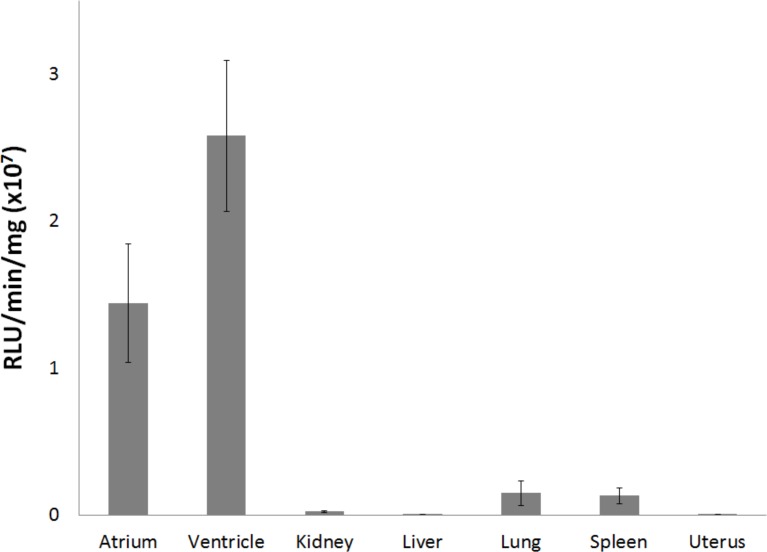
Characterization of luciferase transgenic mice.Average luciferase activity (±SE) of selected tissues obtained from PLB-Luc transgenic mice (n = 5).